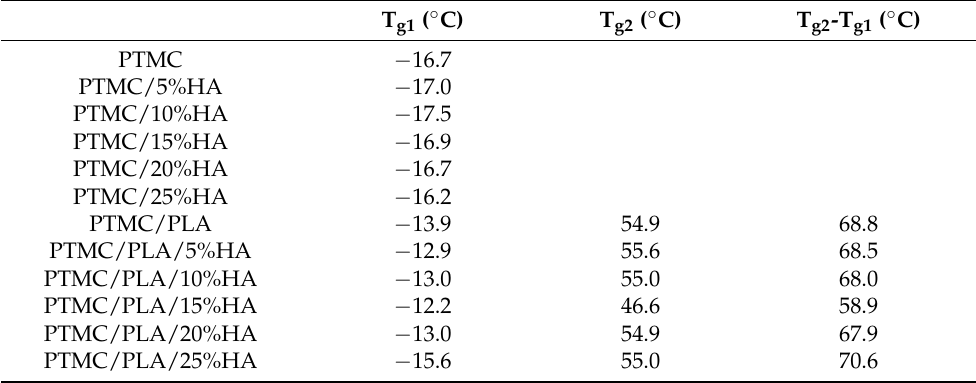
Figure 2. DSC ( a ) and TG ( c ) of PTMC/HA; DSC ( b ) and TG ( d ) of PTMC/PLA/HA scaffolds. Table 1. DSC data of PTMC/HA and PTMC/PLA/HA scaffolds.